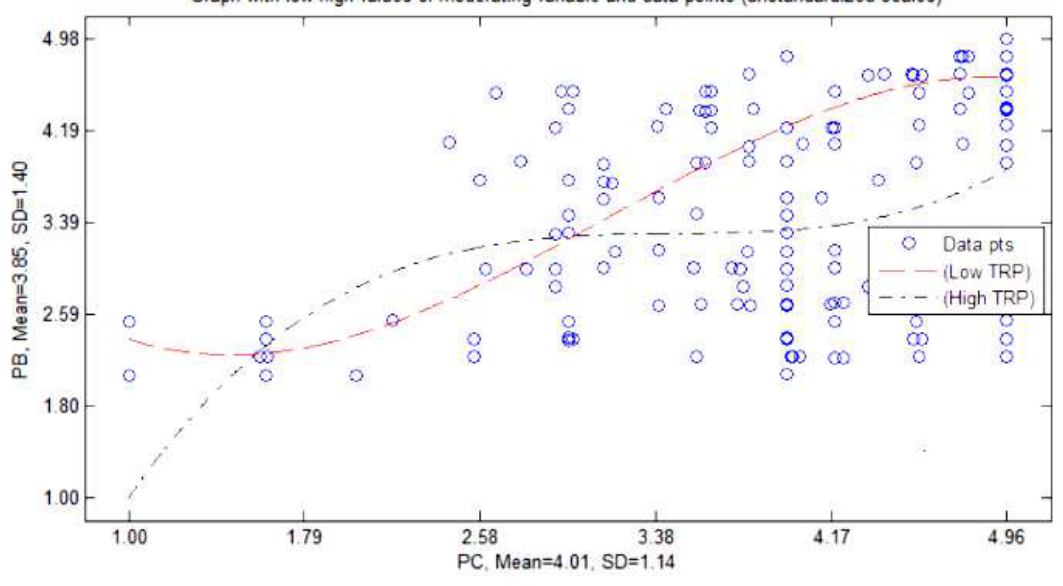
Figure 4. Graph of moderator